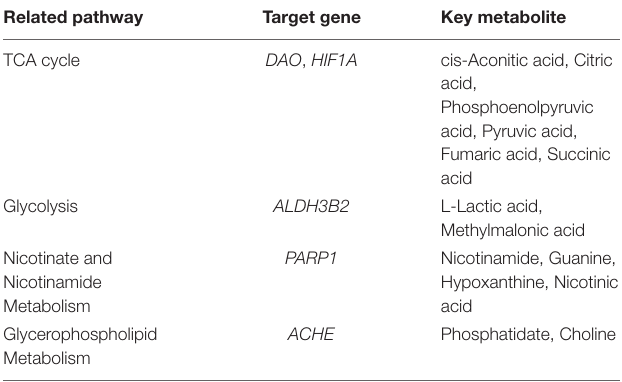
TABLE 5 | The information of key targets, metabolites, and metabolic pathways. Related pathway Target